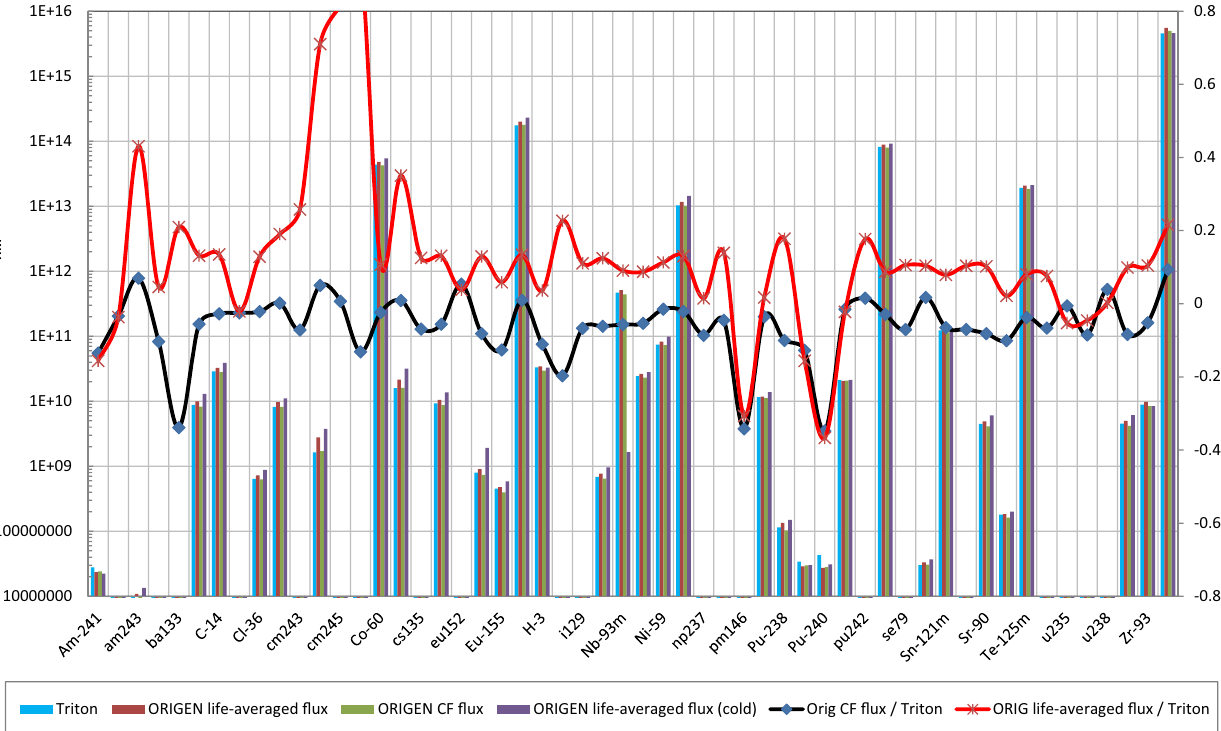
Fig. 2. Speci fi c activities and deviations between TRITON and ORIGEN-S for the UO 2 PWR case (4.4% enrichment, burnup = 55 GWd/t, CT = 60